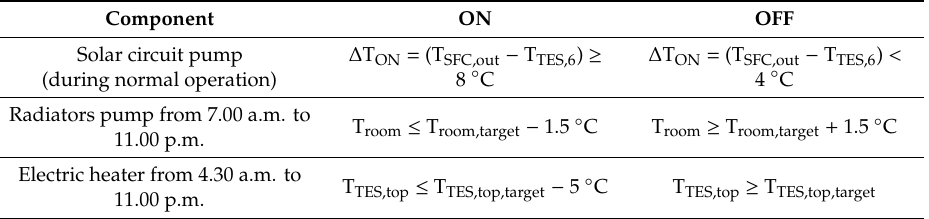
Table 5. The main control algorithms and strategies of the proposed system (PS). Component ON OFF Solar circuit pump (during normal operation)